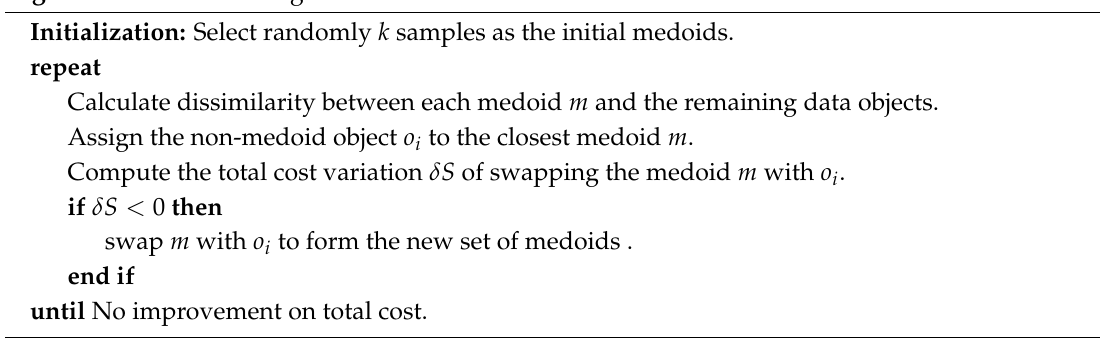
Algorithm 1 k -medoids